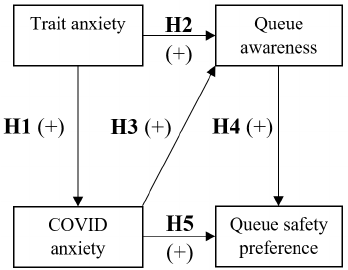
Figure 1. The hypothesised